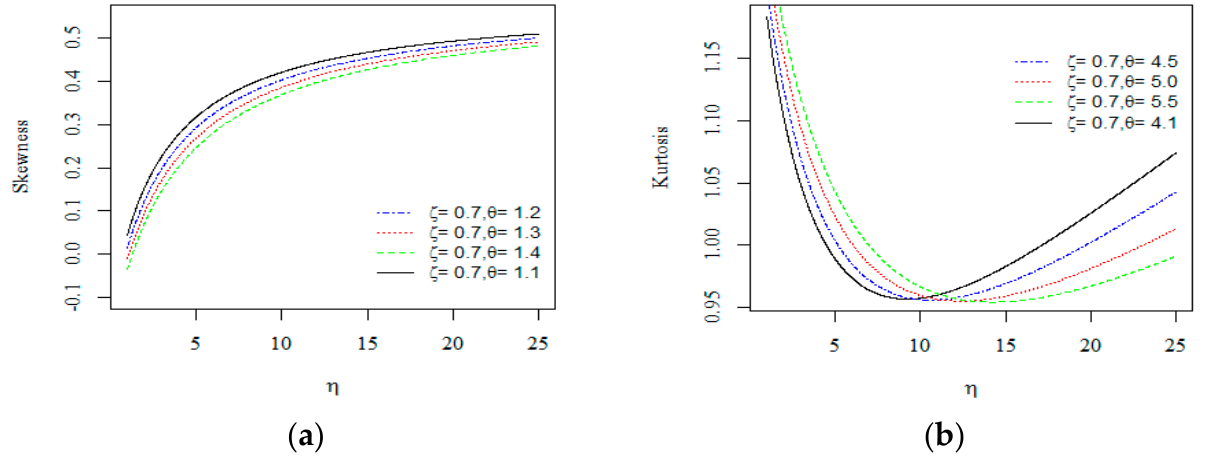
Figure 3. Plots of the skewness ( a ) and kurtosis ( b ) of the E-NPF distribution.